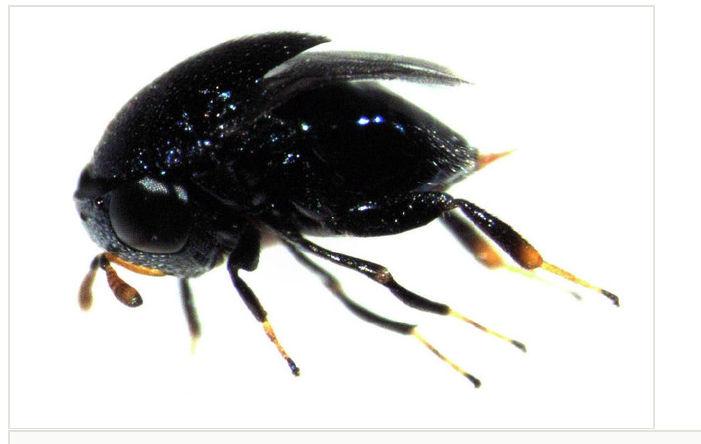
Scutellista caerulea , adult female in lateral view (length about 2